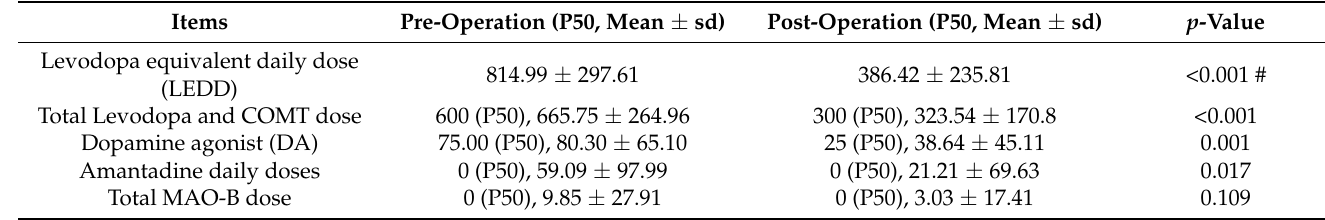
Table 3. The list of drugs used in pre- and postoperative treatment for the RLS group.